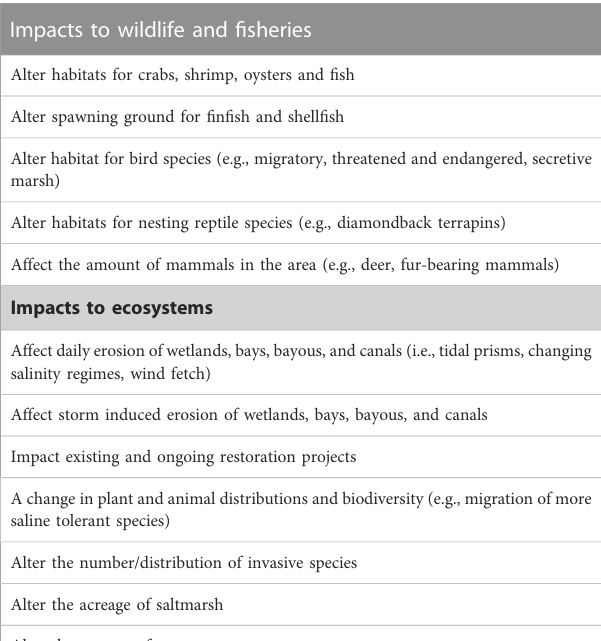
TABLE 3 Option questionnaire assessment